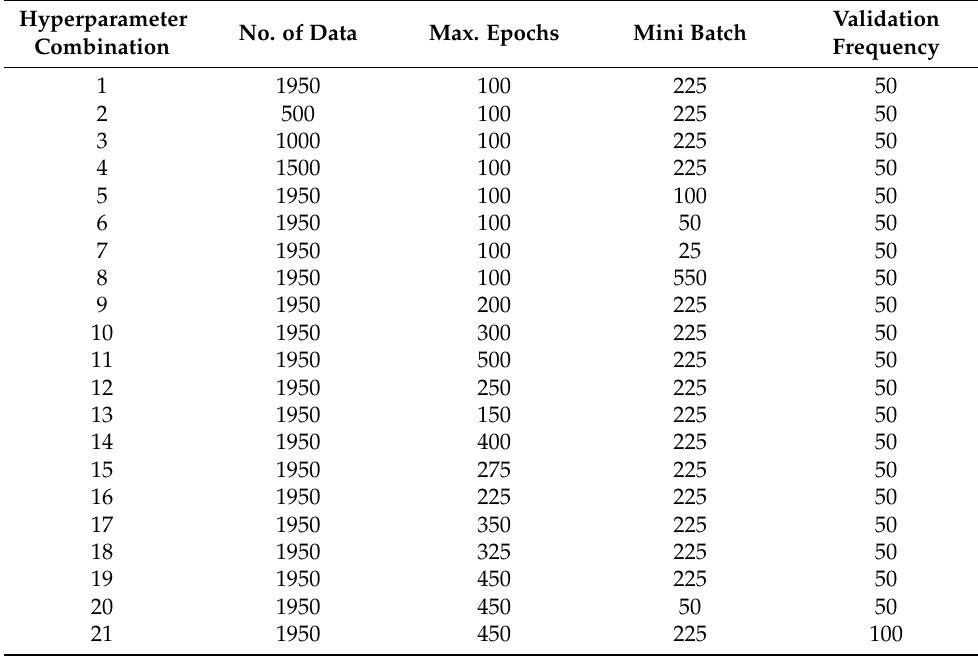
Table 1. Considered combinations of the LSTM hyperparameters and number of data. With all of them, the Adam optimizer, initial learning rate 1 × 10 − 3 were